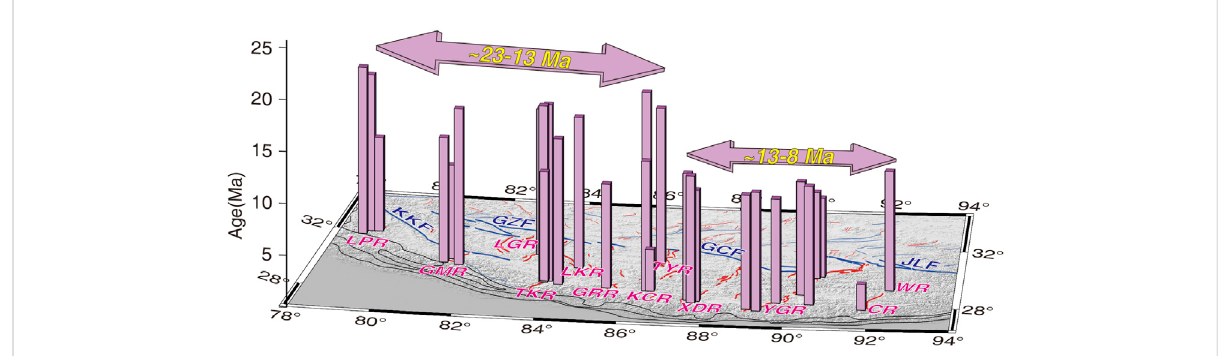
FIGURE 7 Distribution ofonsettimingforthemain~NS-trendingriftsinsouthernTibet.Themajorityofagesshowsoldinitiationtimingfrom~23to13 Ma west of Xainza-Dinggye rift (XDR) and young onset timing from ~13 to 8 Ma east of XDR. CR, Cona rift; GMR, Gurla Mandhata rift; GRR, Gyirong rift; KCR, Kung Co rift; LGR, Lunggar rift; LPR, Leo Pargil rift; TKR, Thakkhola rift; WR, Woka rift; XDR, Xainza-Dinggye rift; YGR, Yadong-Gulu rift. GCF, Gyaring Co fault; GZF, Gaize fault; JLF, Jiali fault; KKF, Karakorum